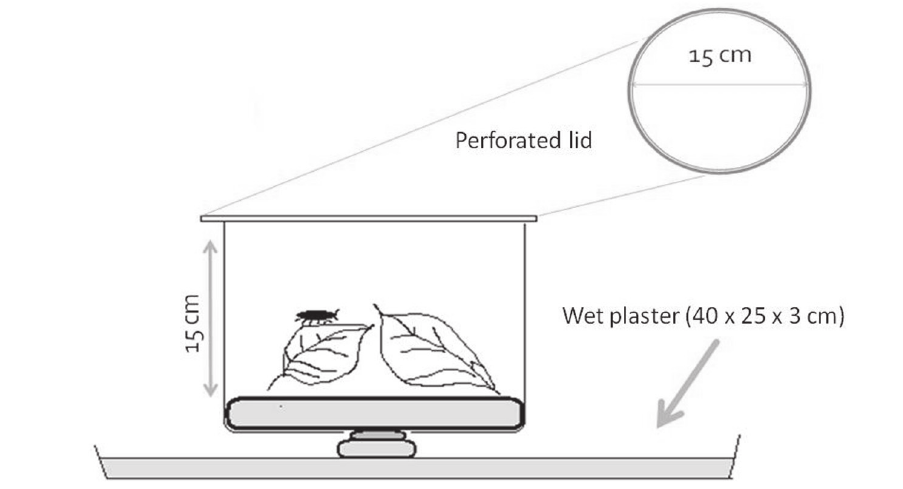
Figure 2. Schematic figure of a microcosm showing dimensions of the transparent plastic container and the plaster layer